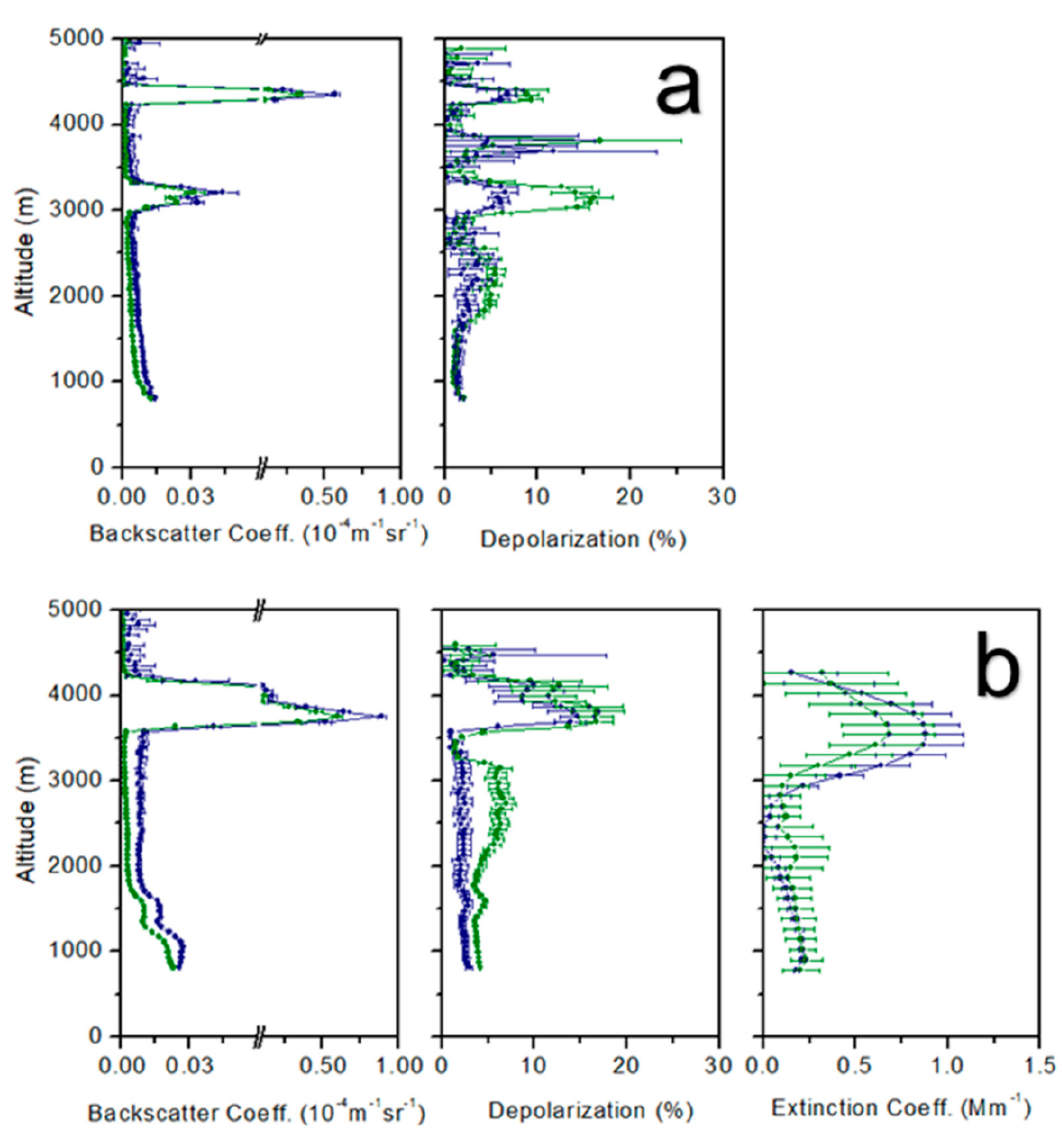
Figure 5. ( a ) Aerosol backscattering coe ffi cient (10 − 4 m − 1 sr − 1 ) and linear depolarization (%) of Lidar measurements carried out at 11:49; ( b ) aerosol backscattering coe ffi cient (10 − 4 m − 1 sr − 1 ), linear depolarization (%) and aerosol extinction coe ffi cient (10 − 3 m − 1 ) of Lidar measurements carried out at 15:37. For both measurements, the laser wavelengths are 355 nm (blue line) and 532 nm (green